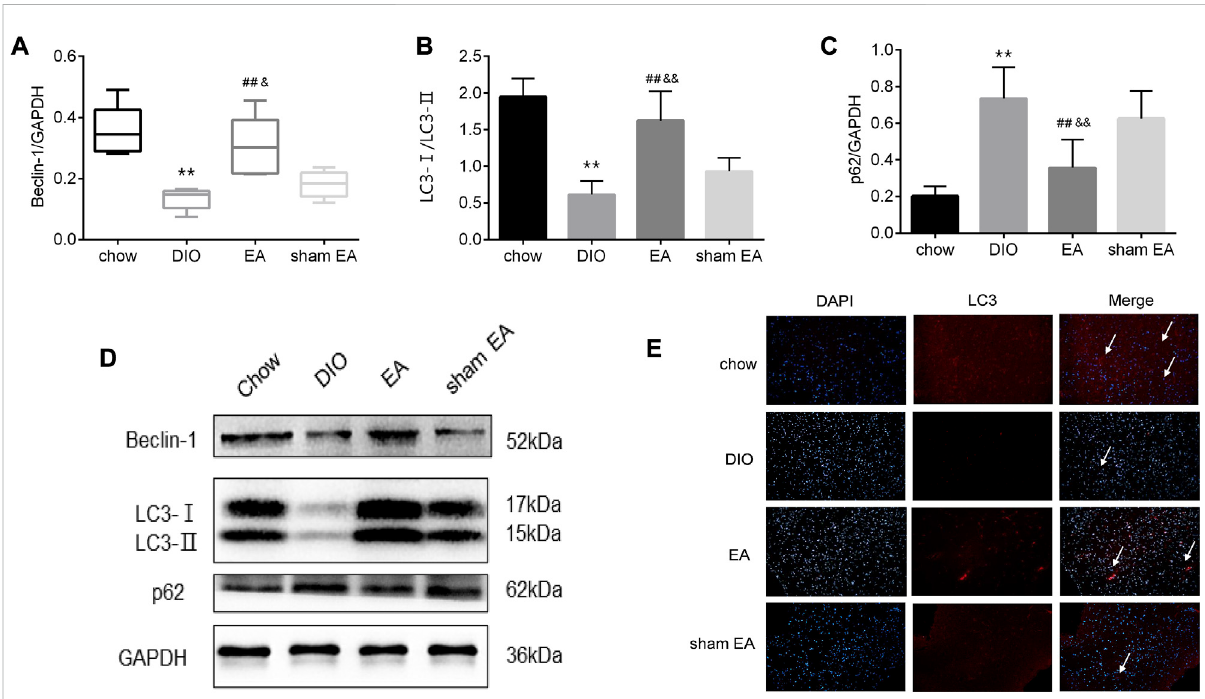
FIGURE 4 EA treatment alters the expression of autophagy-related biomarkers in the hypothalamus. (A) Relative protein expressions of Beclin-1, (B) LC3- Ⅰ /LC3- Ⅱ , and (C) p62 detected by Western Blot; (D) immunoblot image showing Beclin-1, LC3- Ⅰ /LC3- Ⅱ , and p62; (E) representative images showing DAPI(blue)andLC3(red) fl uorescence(scalebar,100 μ m).ThewhitearrowsinthemergedimagesindicateLC3.DataareexpressedasMean±SDor Median (IQR) ( n = 2 rats per group for IF, and n = 5rats per group for others), ** p < 0.01 vs. chow; ## p < 0.01 vs. DIO; && p < 0.01 vs. sham EA.EA, electroacupuncture; DIO, diet-induced obesity; IF, immuno fl uorescence. EA treatment decreased mTOR and p70S6K protein expression in the hypothalamus.